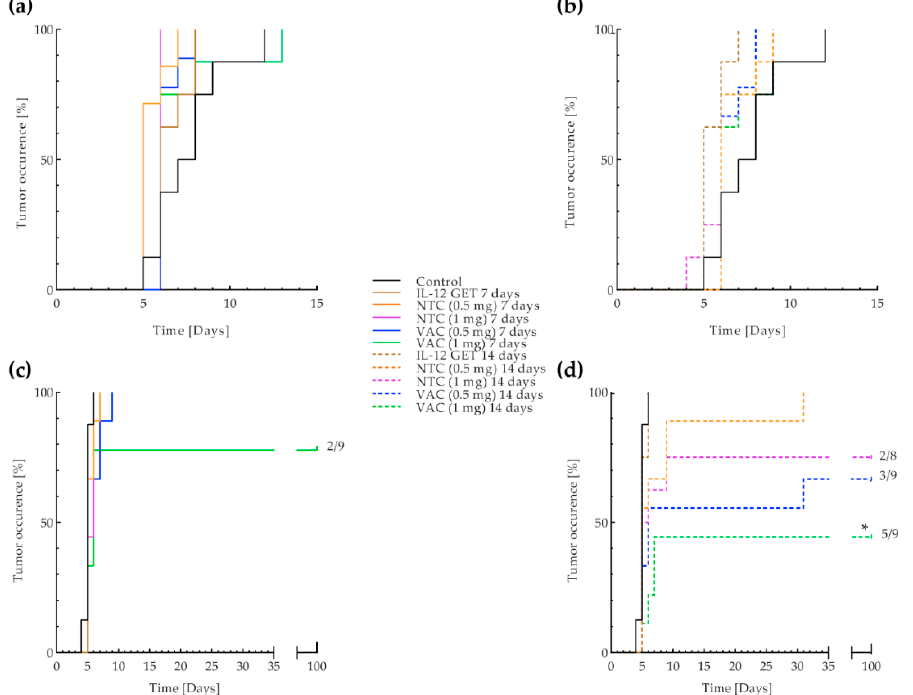
Figure 6. B16 ‐ F10 and CT26 preventative vaccination. Kaplan–Meier analysis of ( a ) preventative B16